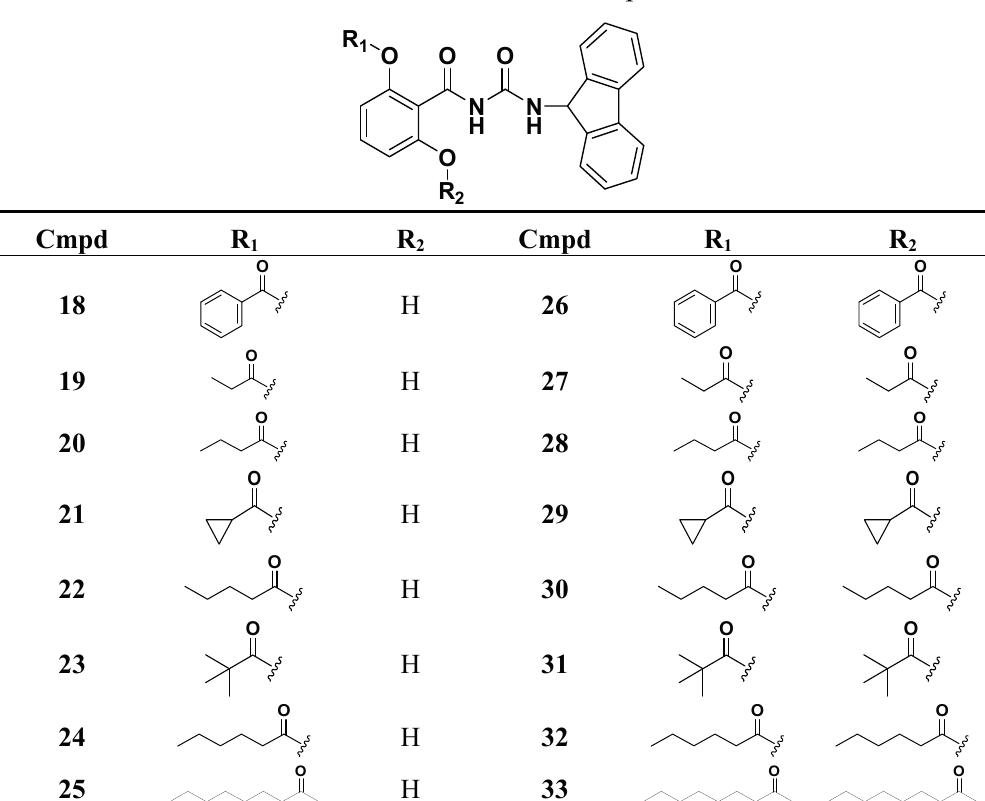
Table 3. Chemical structures of compounds 18 – 33